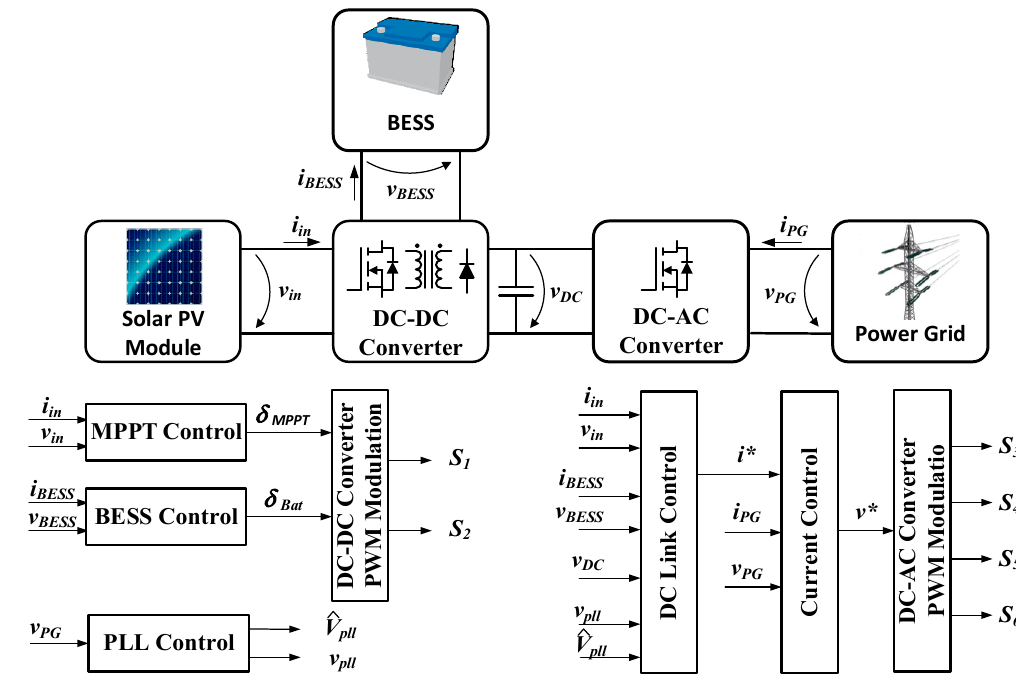
Figure 7. Block diagram of the microinverter with the integration of the control algorithms.